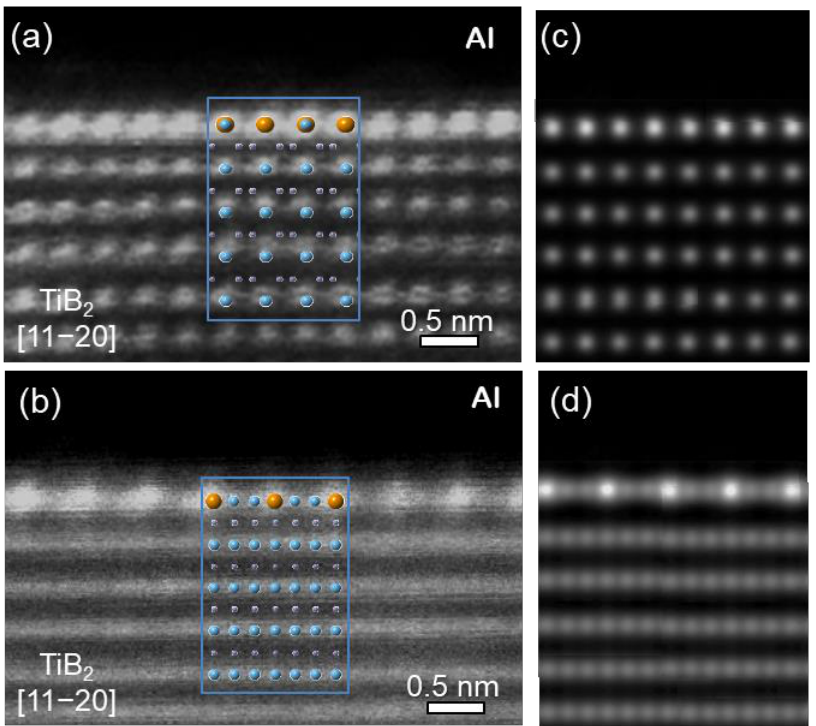
Figure 11. Formation of Zr segregation layer (Ti 2 Zr 2DC) at Al/TiB 2 interface [26,27]. ( a , b ) STEM- HAADF images compared with ( c , d ) simulated ones in [1 1 2̅ 0]TiB 2 and [1 0 1̅ 0]TiB 2 direction, respectively. The simulation STEM HAADF images was carried out using the QSTEM multi-slice simulation package developed by Koch [42] according to the constructed super-lattice structure of Ti 2 Zr 2DC based the experimental HR-STEM observation.